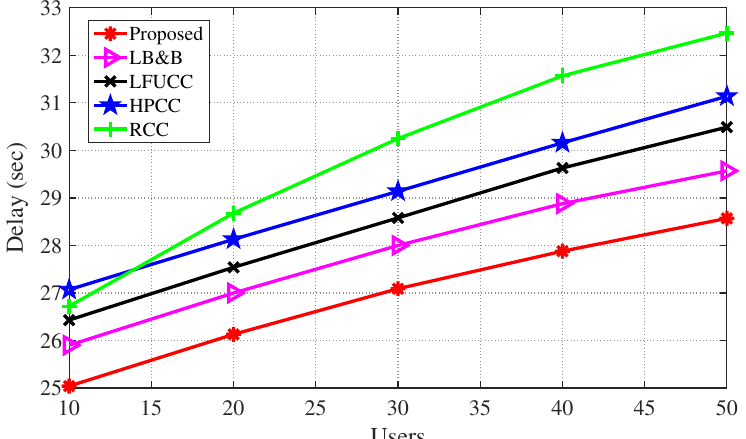
Figure 4. Network delay vs. popularity skewness ( γ ) under various caching schemes when N = 50 and F = 400.